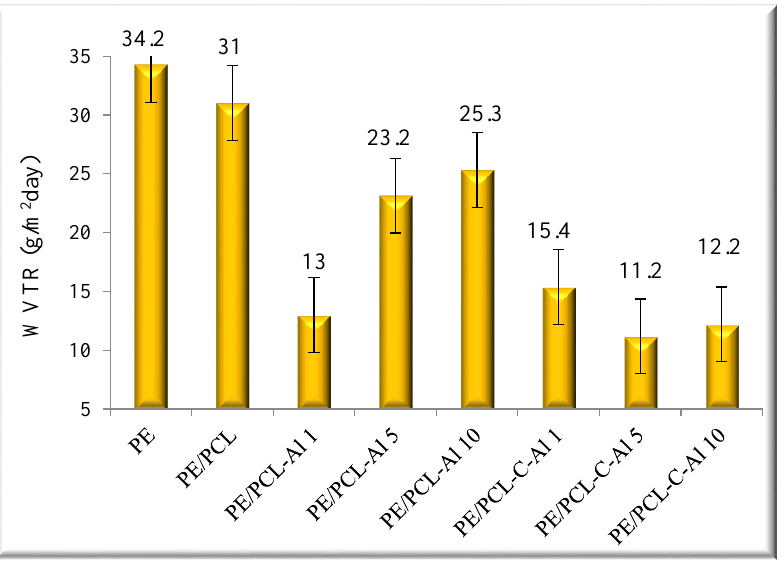
Figure 1. The water vapor permeability of pure PE, PE/PCL, and modified PE/PCL films .